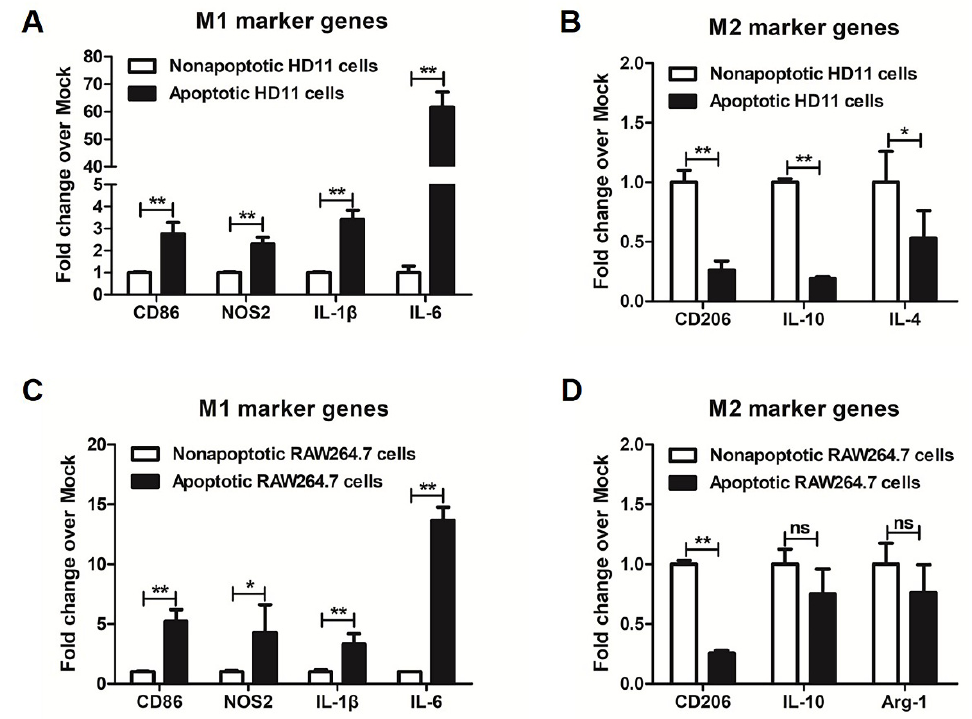
Figure 2. The influence of metformin on M1 and M2 marker genes in apoptotic macrophages. RT-qPCR analysis of M1 ( A ) and M2 ( B ) marker genes in apoptotic and nonapoptotic chicken macrophages separated from 25 mM metformin-treated chicken HD11 cells for 48 h. RT-qPCR analysis of M1 ( C ) and M2 ( D ) marker genes in apoptotic and nonapoptotic macrophages separated from 5 mM metformin-treated mouse RAW264.7 cells for 48 h. * represents p < 0.05 and ** represents p < 0.01.